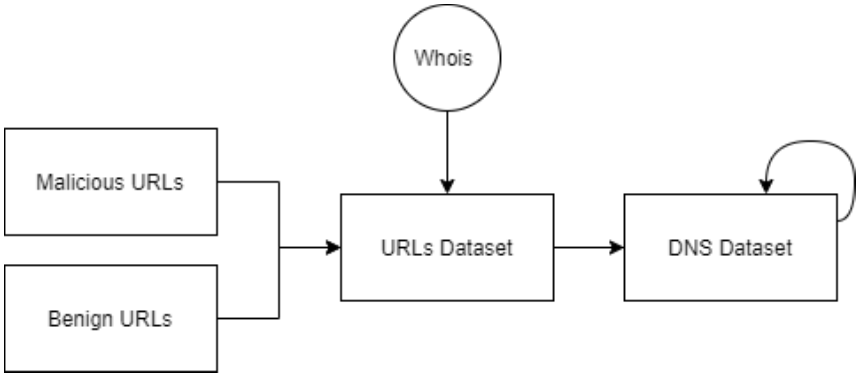
Figure 2. Data collection